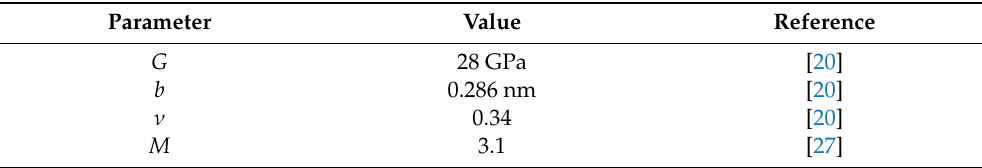
Table 3. Partial physical / mechanical parameters of the Al-Cu-Li